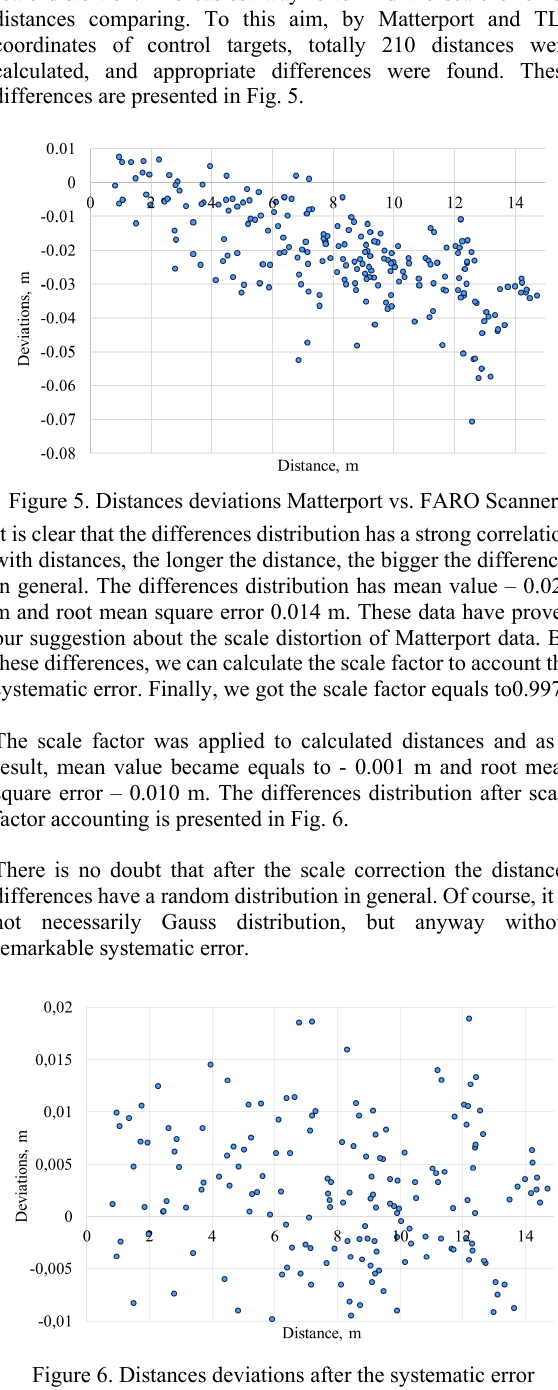
Table 2. Deviations of control targets coordinates after